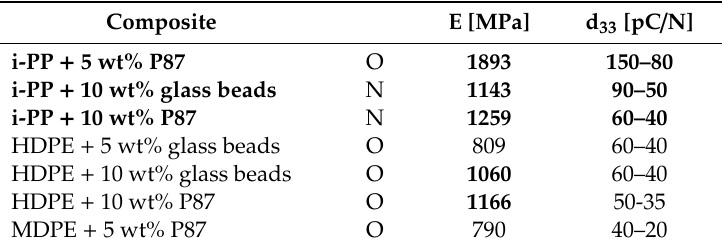
Table 1. Values of Young’s modulus (E) and piezoelectric coe ffi cients (d 33 ) for the selected composite films characterized by the best piezoelectric properties (O: Oriented, N: Non-oriented; the best piezoelectric composites and the highest values of the E and d 33 parameters are signed in bold). Composite E [MPa] d 33 [pC / N] i-PP + 5 wt% P87